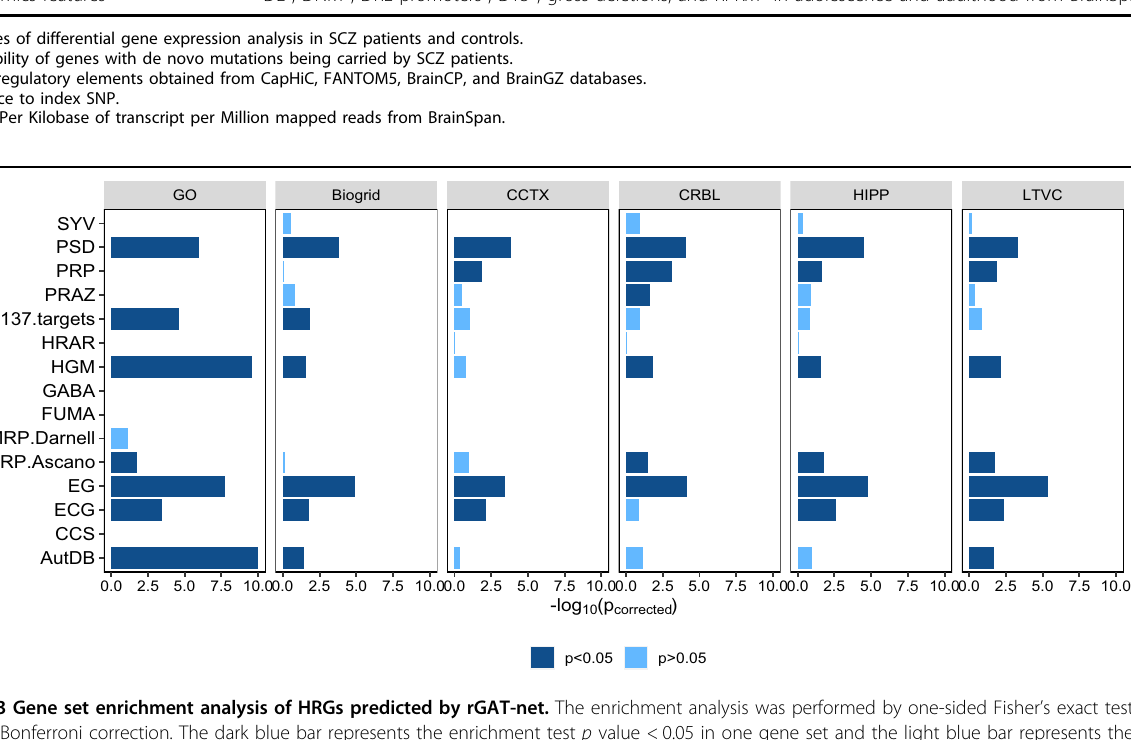
Fig. 3 Gene set enrichment analysis of HRGs predicted by rGAT-net. The enrichment analysis was performed by one-sided Fisher ’ s exact test with Bonferroni correction. The dark blue bar represents the enrichment test p value < 0.05 in one gene set and the light blue bar represents the enrichment test p value > 0.05 in one gene set dataset. The full name and brief description of each dataset are given in Table S2. HRGs predicted by the GO and BioGRID networks are enriched in miR-137 targets that are not enriched by using any networks from the TissueNet database in the prediction. HRGs predicted by TissueNet are all enriched in PRP that are not enriched by the HRGs predicted by using networks from GO and BioGRID. Only HRGs predicted by the CRBL network are enriched in gene set